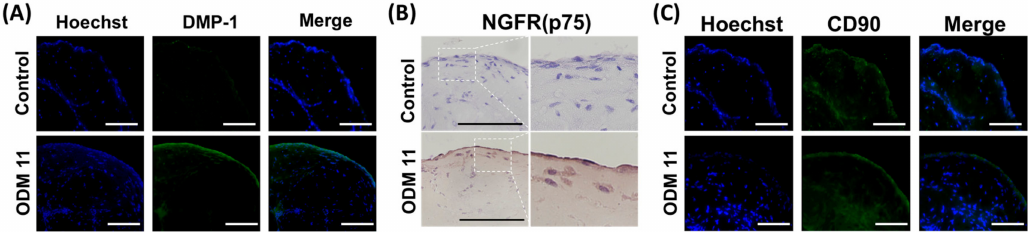
Figure 2. Expression of odontogenic and stem-cell markers in ODM 11 group. Expression of DMP-1 ( A ), NGFR ( B ) and CD90 ( C ) in organoids of control and ODM 11 groups. Blue represents the staining of cell DNA with Hoechst. As expected, the ODM 11 group showed positive staining for DMP-1, NGFR and CD90, but the intensity of CD90 staining was lower in ODM 11 than in the control. The panels show merged confocal images of Hoechst and secondary. Scale bar = 100 µ m.